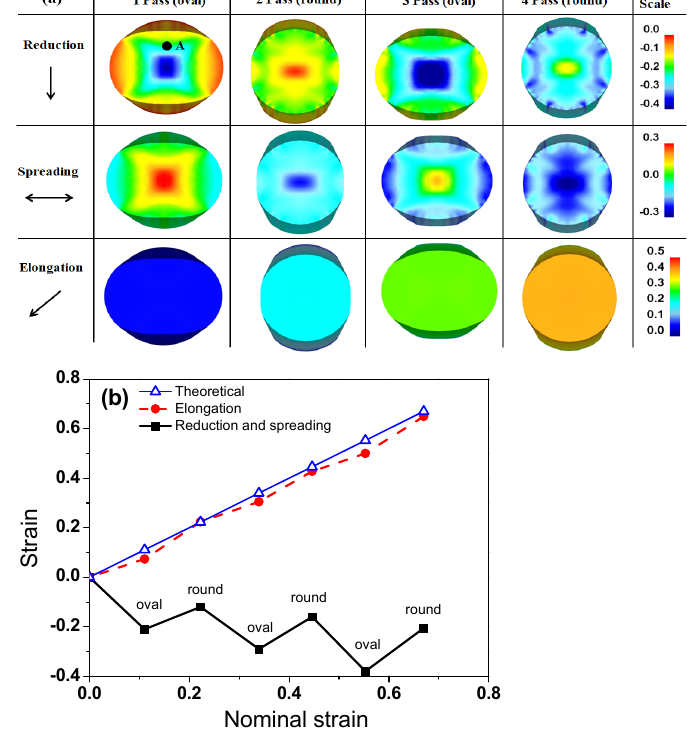
Figure 11. Comparison of the ( a ) strain contour with the direction of the wire and ( b ) variation in stain at point A marked in ( a ) of the caliber-rolled wire with the rolling pass. Theoretical strain was calculated using Equation (2).